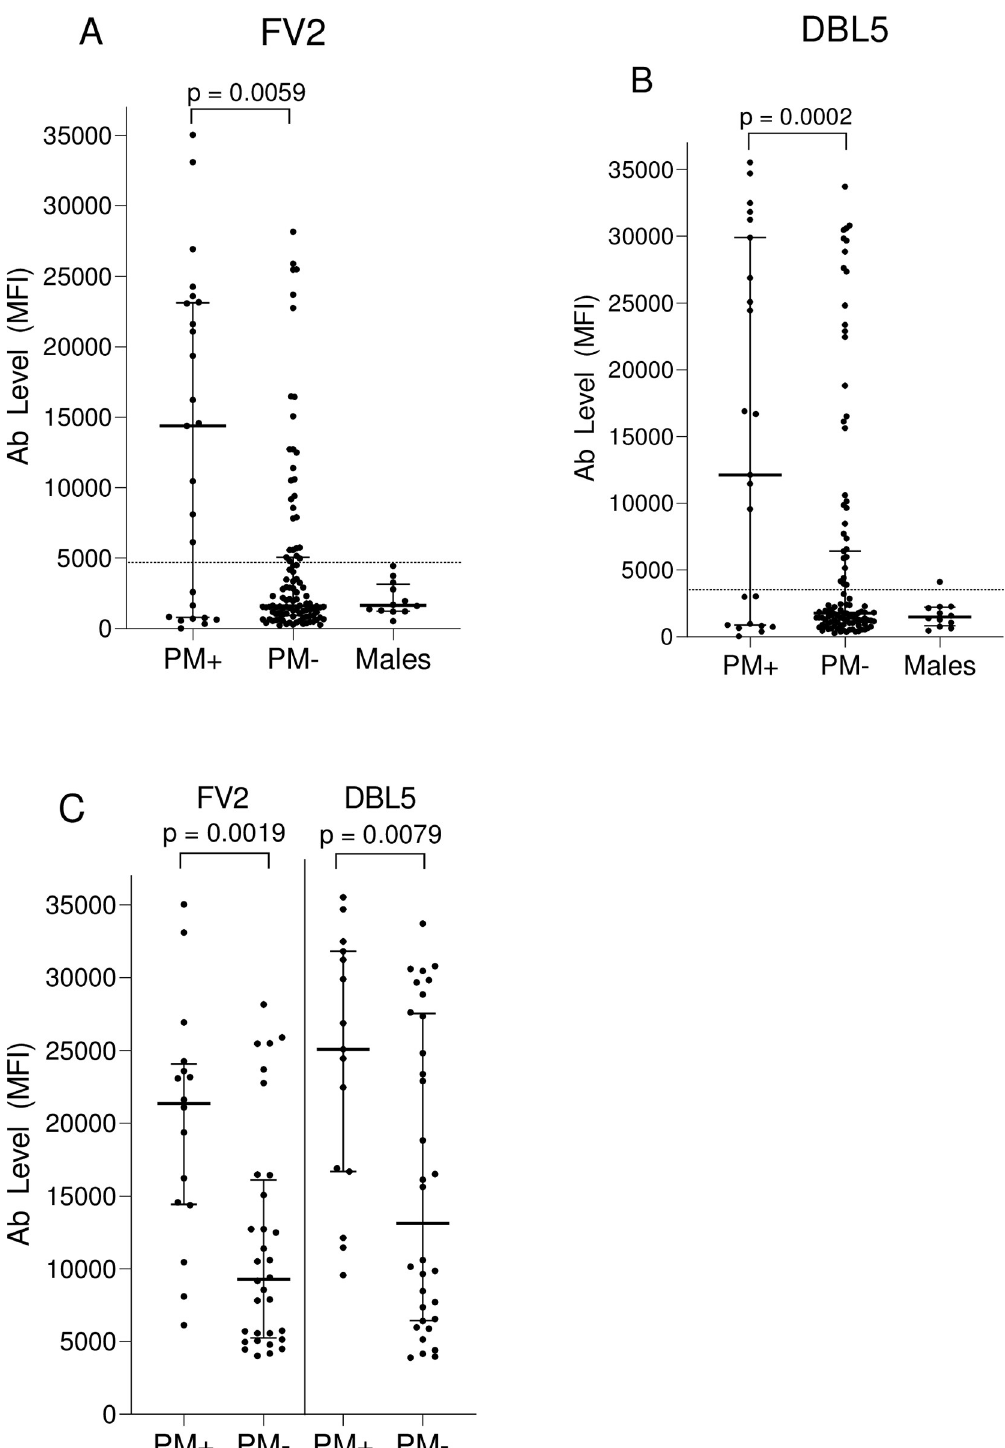
Fig 1. Antibody levels to VAR2CSA (FV2 and DBL5) in PM+ and PM+ women. Plasma Ab levels to VAR2CSA were compared in women by PM status using Mann-Whitney Rank Sum test. A and B: IgG levels for all women (n = 130); C: IgG levels for women who were Ab-positive (i.e., had levels higher than the cut-off (n = 49 women for FV2, n = 47 for DBL5); MFI: median fluorescence intensity; IQR: interquartile range; Ab: antibodies; PM: placental malaria. The horizonal dotted lines show the cut-off for Ab-positive, which was 4,483 MFI for FV2 and 3,232 MFI for DBL-5. Horizontal bars represent the group median +/- 25% IQR.